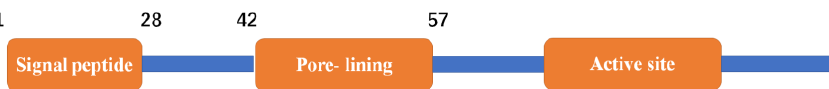
Figure 4. A schematic drawing of the functional domain of G6046. G6046 possesses a signal peptide and a pore-lining helix domain at its N-terminus. Table 1. Constructs of G6046.